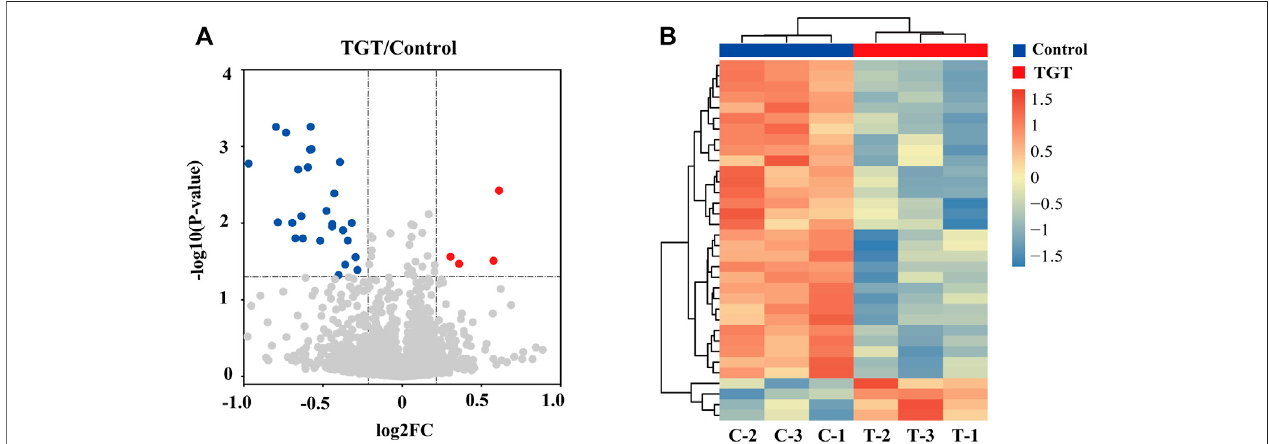
FIGURE 6 | (A) Volcano plot for the TGT group versus control group in rats. The fold change > 1.2 and p < 0.05 indicated differentially expressed proteins. Non- changed proteins are shown in gray color. Red color indicates upregulated proteins and blue color indicates downregulated proteins. (B) Heatmap plot of differentially